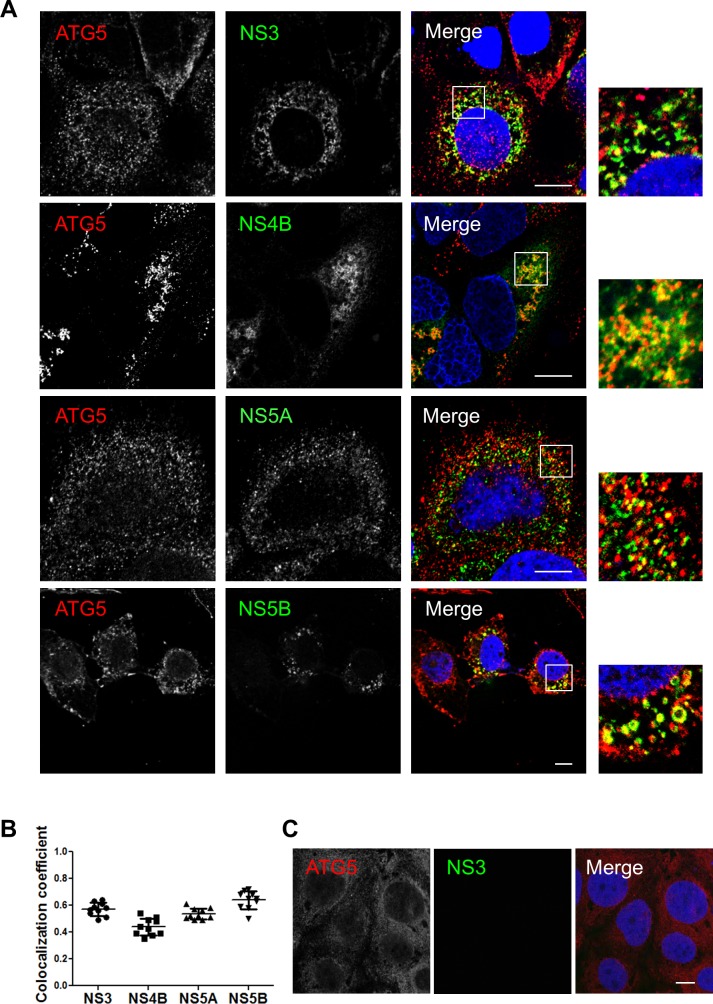
Components of the HCV replicase colocalize with ATG5-12 conjugate in Huh7 cells.A. JFH1-infected Huh7 cells at more than 90% were probed for endogenous ATG5-12 conjugate using a mouse anti-ATG5 antibody and HCV nonstructural proteins (NS3, NS4B, NS5A, and NS5B) using rabbit specific antibodies as described in the materials and methods section. The nuclei were stained with DRAQ5 (blue). Confocal microscopy images displaying subcellular localization of endogenous ATG5-12 conjugate and viral NS3, NS4A, NS5A, and NS5B in merged image panels are shown. Marked colocalization between endogenous ATG5-12 conjugate and components of the viral replicase (NS3, NS5A, and NS5B) or the membranous web (NS4B) was observed. Scale bar, 10μm. B. The average of colocalized pixels of ATG5-12 and HCV nonstructural proteins (n = 5 cells, 10 arbitrary positions) was determined. The values of overlapping fluorescence signal with HCV nonstructural proteins were calculated using Manders’ colocalization coefficient. C. Localization of ATG5-12 in uninfected cells. Uninfected Huh7 cells were immunostained for ATG5-12 using a mouse anti-ATG5 antibody. Scale bar, 10μm.